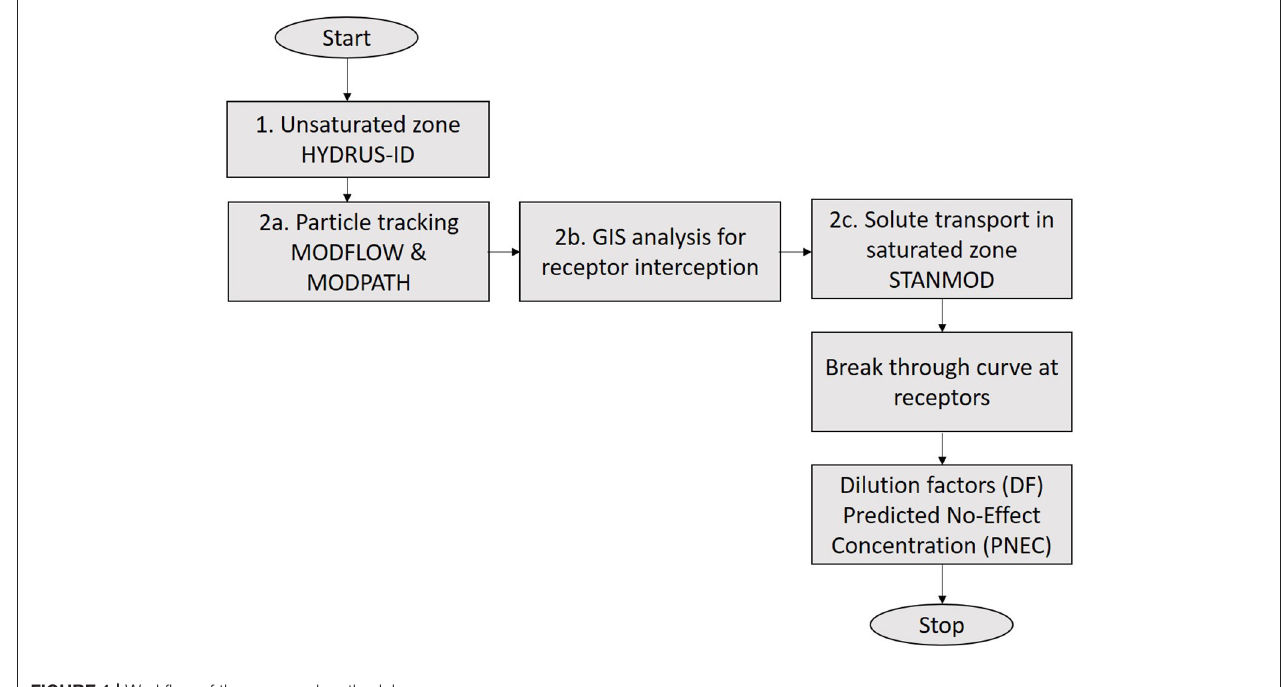
FIGURE 1 | Workflow of the proposed methodology.